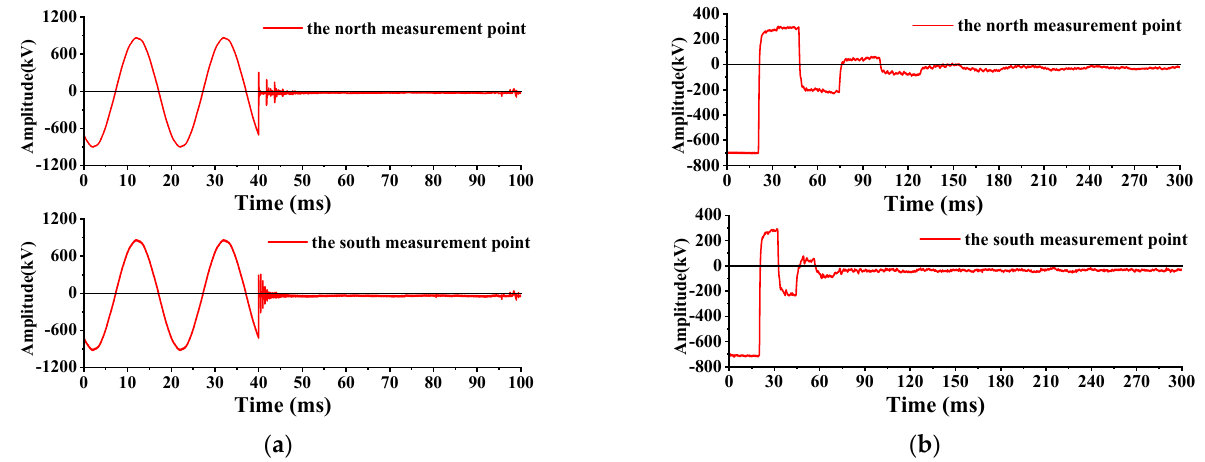
Figure 7. Transient voltage waveform generated in a phase of operating 1100 kV GIL. ( a ) Full recorded waveform within 100 ms; ( b ) an expanded view of the transient waveform.